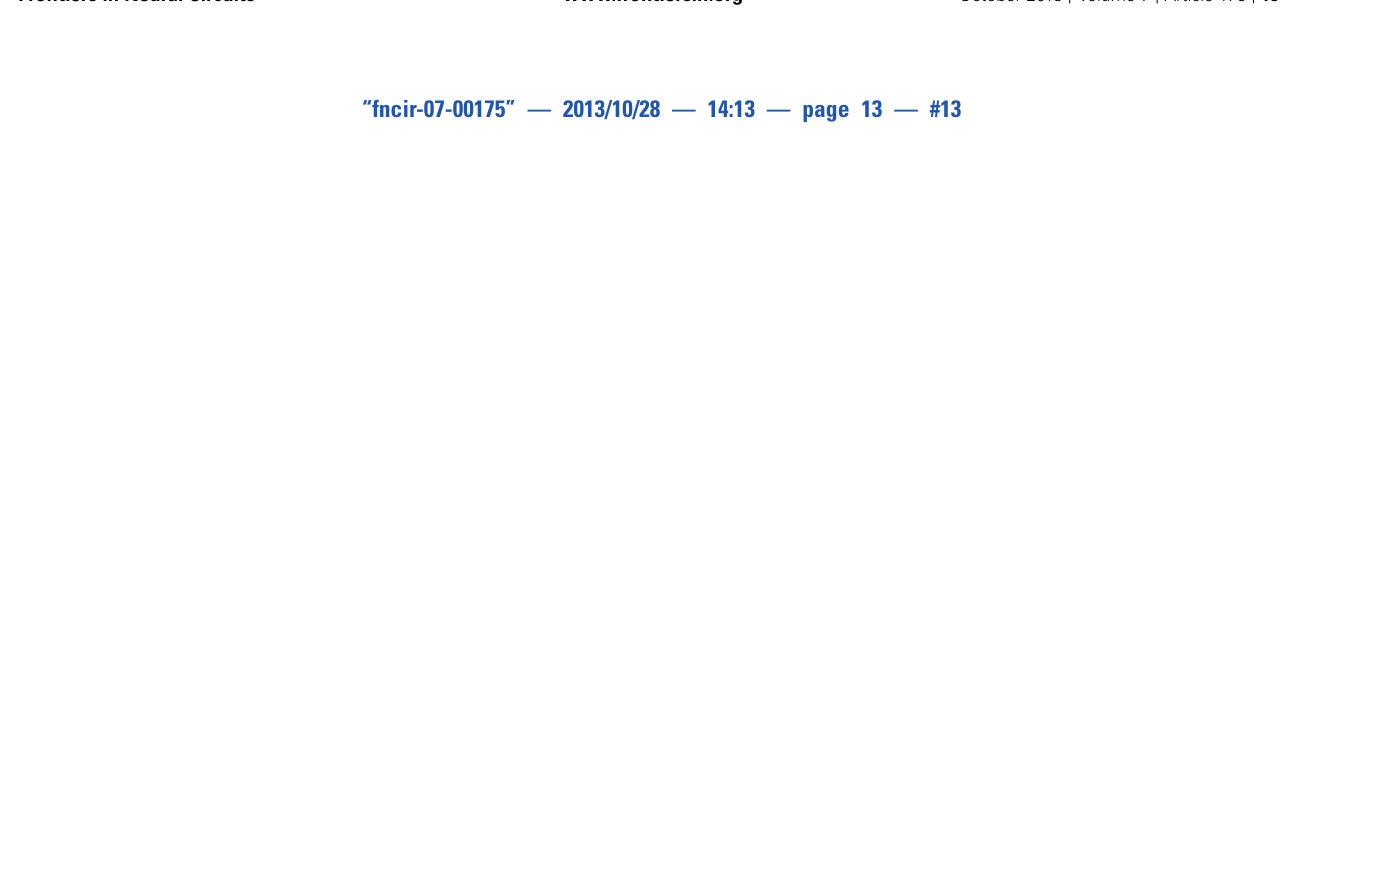
larger effect ∼ 20 ms after tone onset and 20 dB above threshold. (B) In a second neuron, HiDi does not affect firing at 15 dB SPL, but reduces firing at 25 dB SPL which corresponds to the peak of the control RIF (right column). HiDi has almost no effect at intensities corresponding to the downward limb of the RIF. HiDi does not affect responses soon after onset (top graph, right column), but its effect in successive time windows is